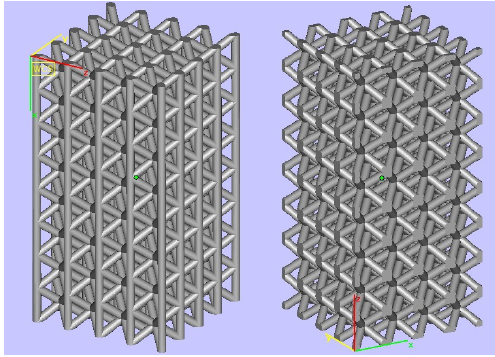
Figure 1. 3D models of trabecular specimens with bcc-z and bcc cell type. Table 1. List of specimens produced and their